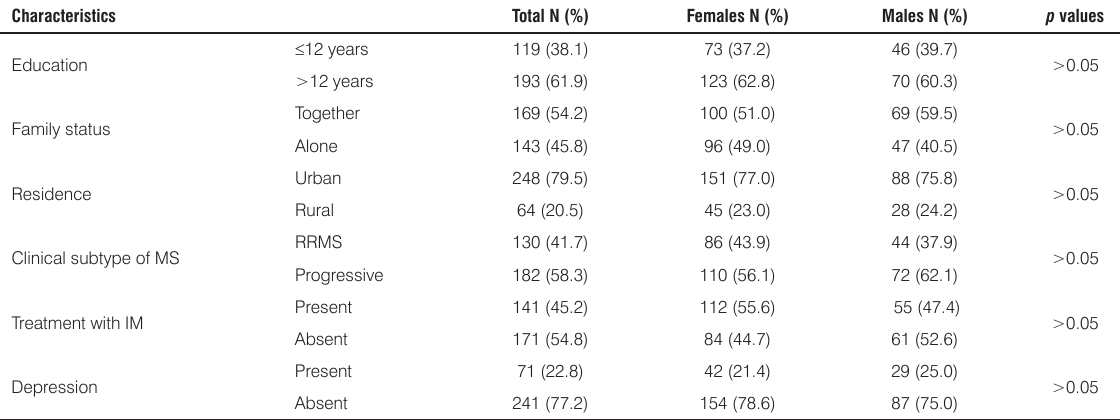
Table 2. Socio-demographic and clinical characteristics by Characteristics